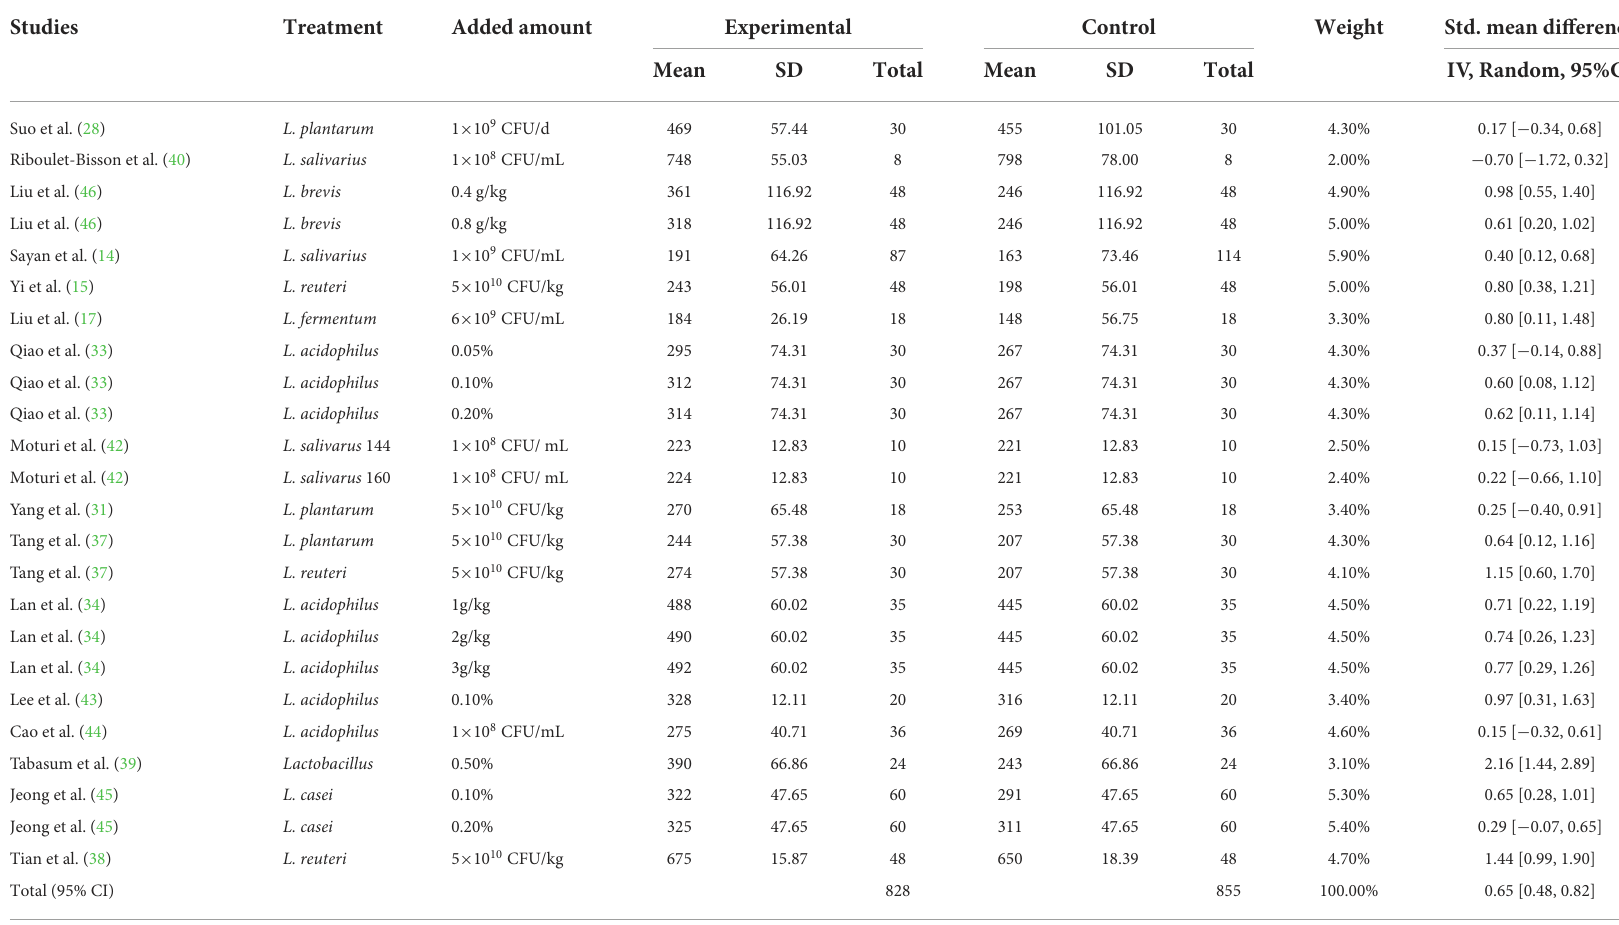
TABLE 2 Effects of Lactobacillus –based probiotics on the average daily gain (ADG) of pigs from included studies.